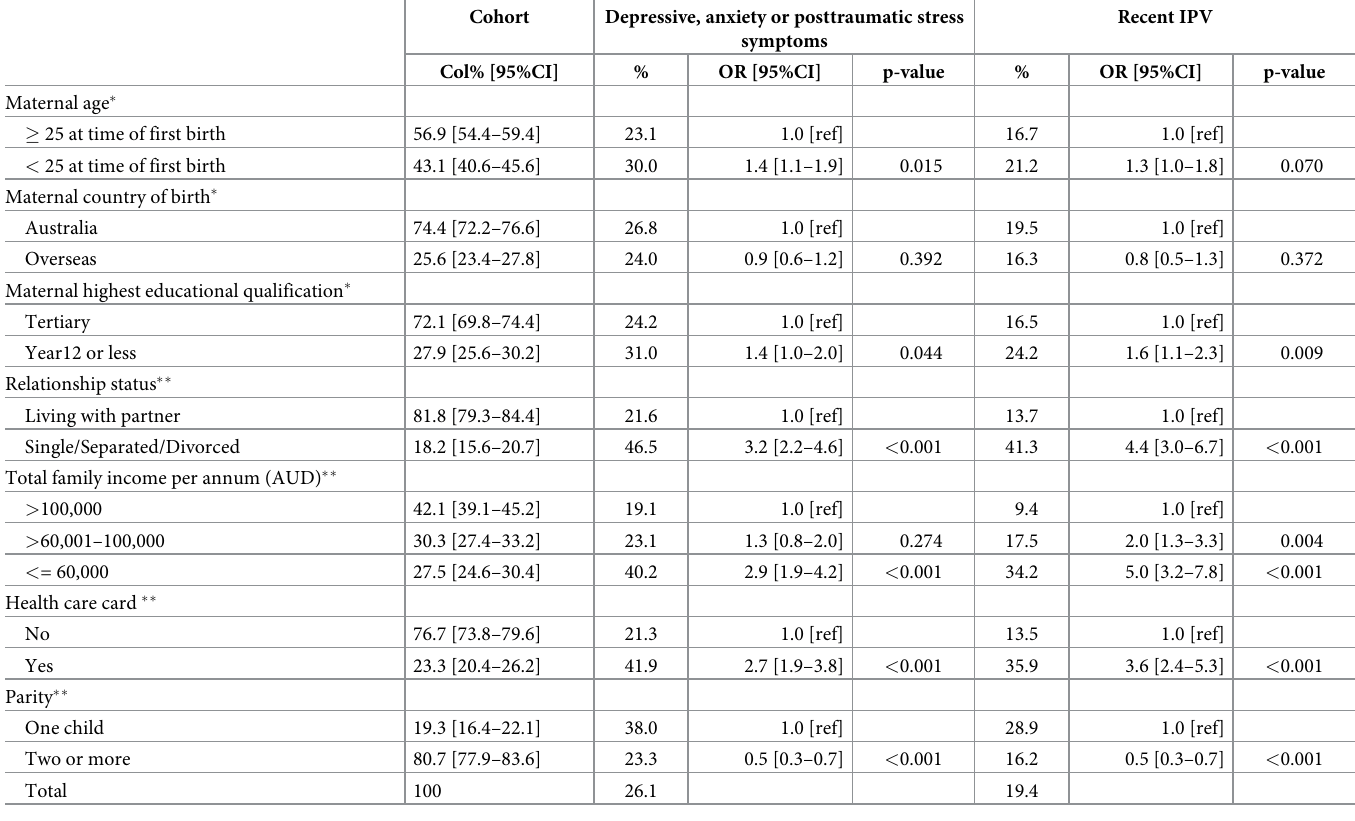
Table 1. Characteristics of women experiencing mental health symptoms and recent IPV at 10-year follow-up (n =